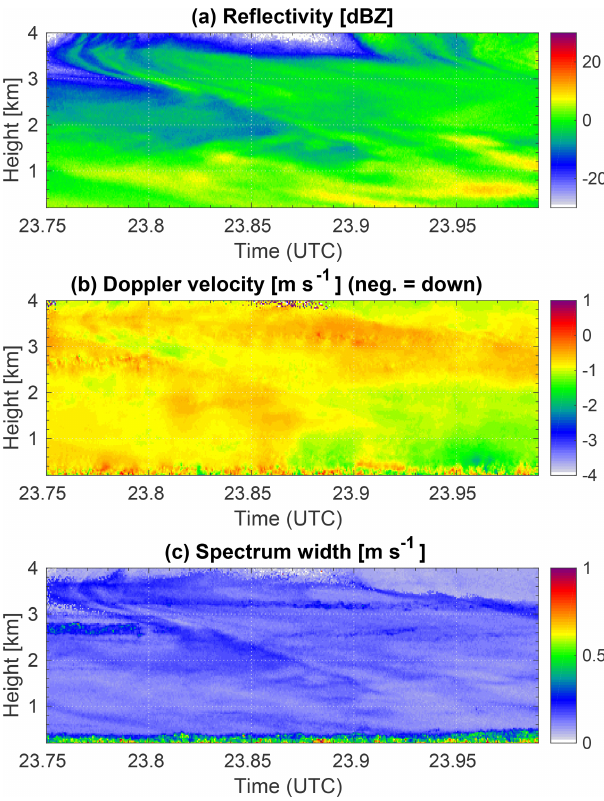
Figure C1. Like Fig. 4 but for 7 February 2014, 23.75–24UTC, at 0.2–4km height.